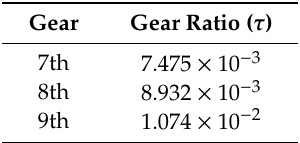
Table 3. Gear ratios for tested gears.